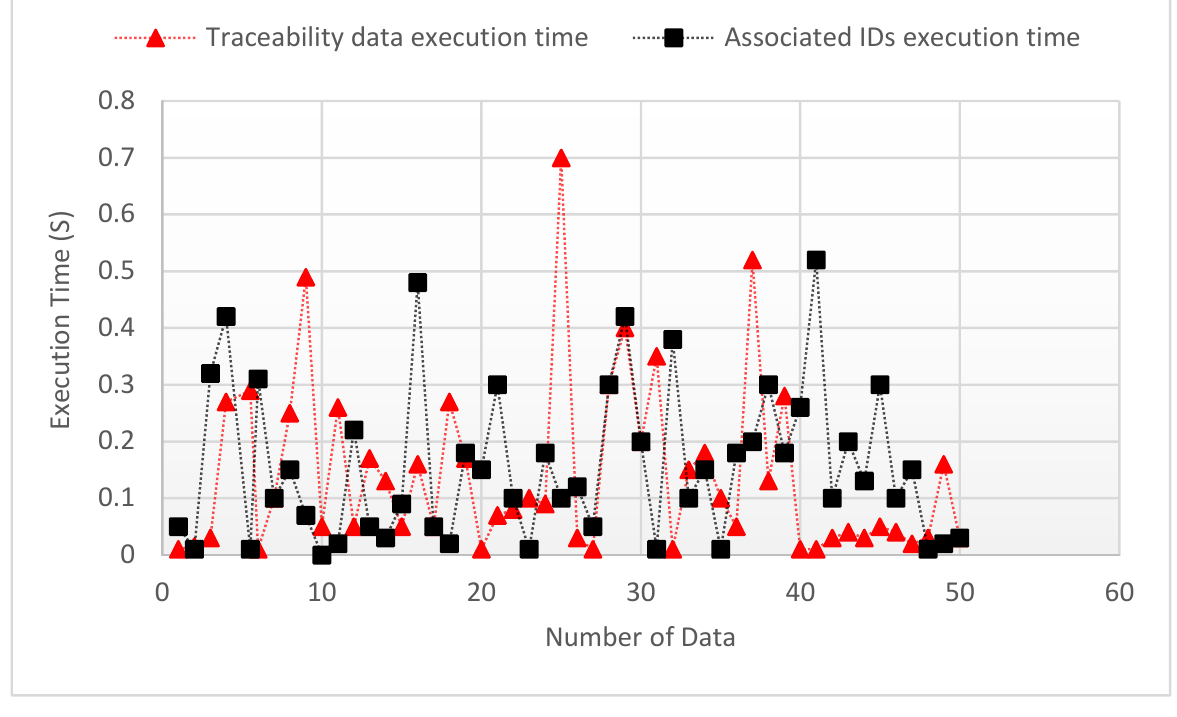
Figure 12. Key performance results of the traceability system.